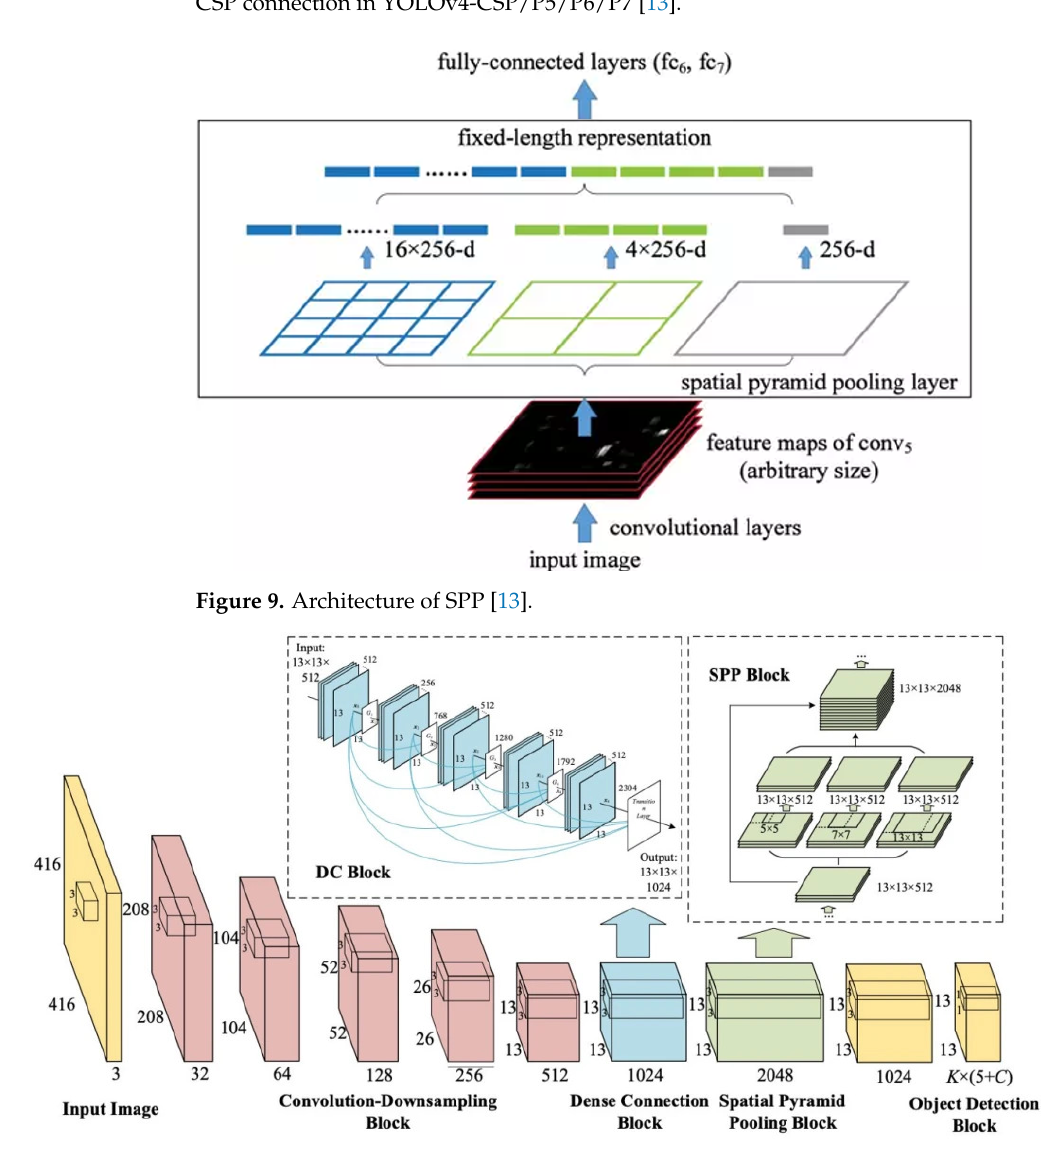
Figure 10. The architecture of YOLO-SPP bypasses the DC Block part